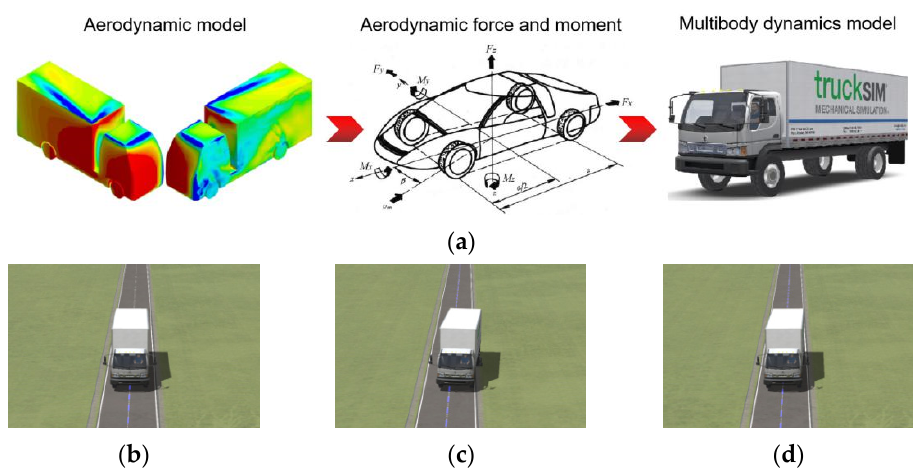
Figure 17. Calculation method of aerodynamic stability (( a ) Analysis process of driving stability; ( b ) driving state without crosswind action; ( c ) driving state with crosswind action; ( d ) driving state with driver feedback control).